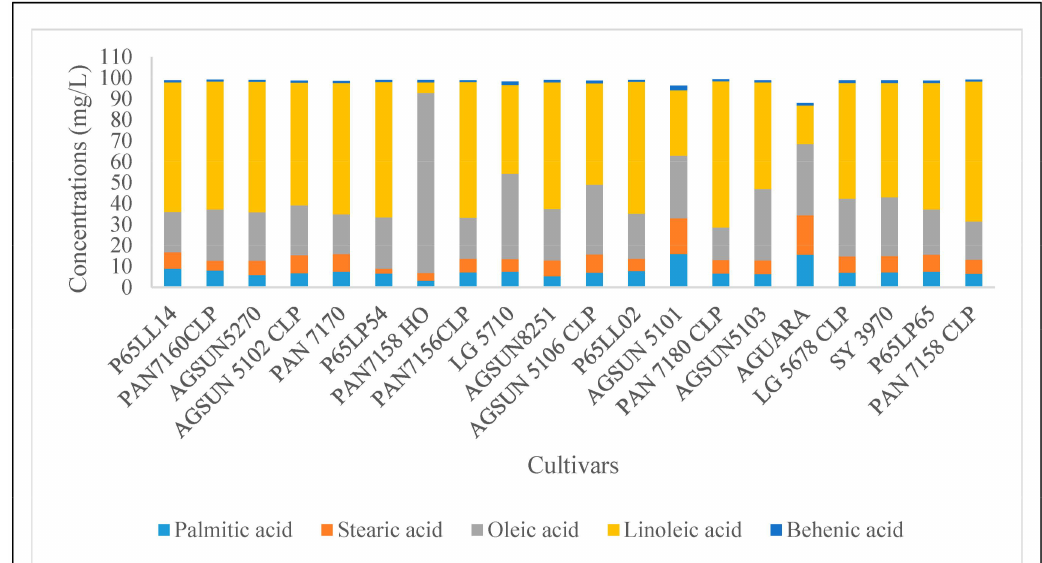
Figure 1. Fatty acid abundance in different cultivars of sunflower seeds oil. Linoleic acids dominated most of the cultivars except PAN7158 HO followed by oleic acid. AGUARA where the stearic acid was most abundant revealed a moderate proportion with other major fatty acids such as linoleic acids and palmitic acids. (Figure only depicted the five major fatty acids, different concentrations of other fatty acids are presented in Supplementary Table S1).